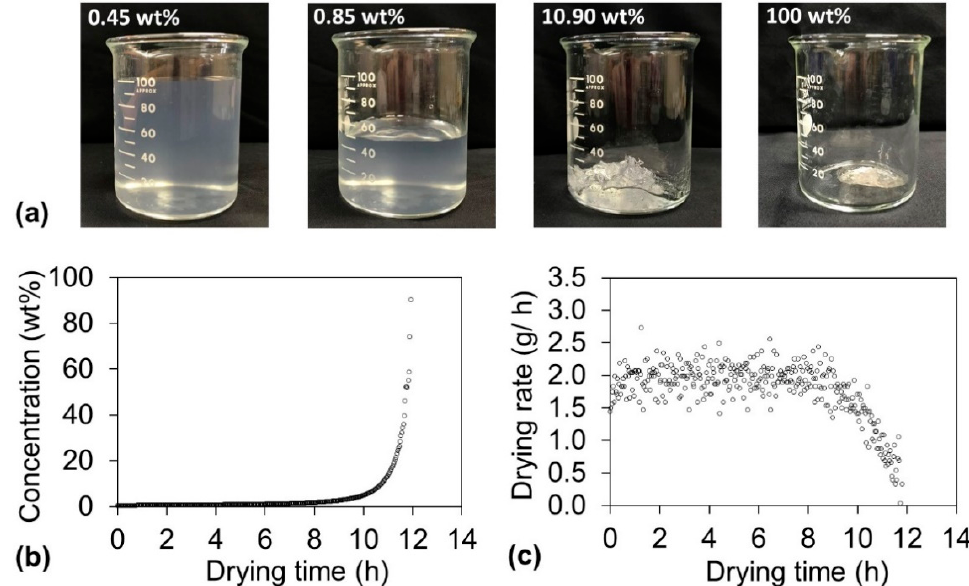
Figure 3. ( a ) Change of appearance of cellulose nanofiber dispersion during drying. The original dispersion was liquid-like at a concentration of 0.45 wt% and maintained the same appearance until 0.85 wt%. As the water evaporation proceeded, at approximately 10 wt%, the dispersion became paste-like and finally became a solid. ( b ) Dispersion concentration and ( c ) drying rate change as a function of drying time at 55 °C and 55% RH.